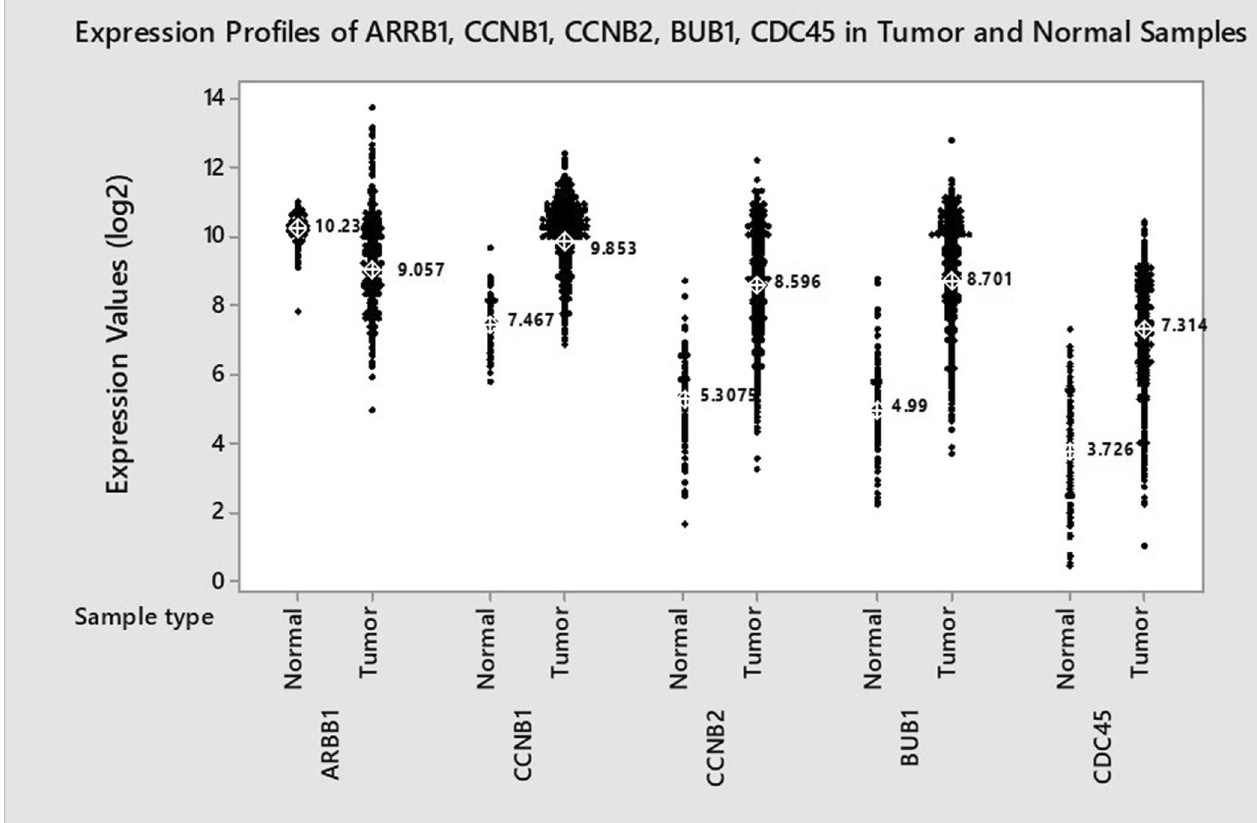
Figure 7. TGCA data analysis and expression profile of βArr1, CDC45, BUB1, CCNB1, CCNB2. The expression profiles of the genes in 114 normal samples and 1097 primary tumour samples obtained from TCGA are shown in individual value plots. The median expression values are marked for each sample type on the graph. When the expression profiles of βArr1(ARRB1) and cell cycle genes were evaluated in tumour and normal samples obtained from the TCGA data set, ARRB1 expression was found to be significantly downregulated in tumour samples compared to normal samples (t-test; p = 1.35977E −33 ). Contrary to ARRB1